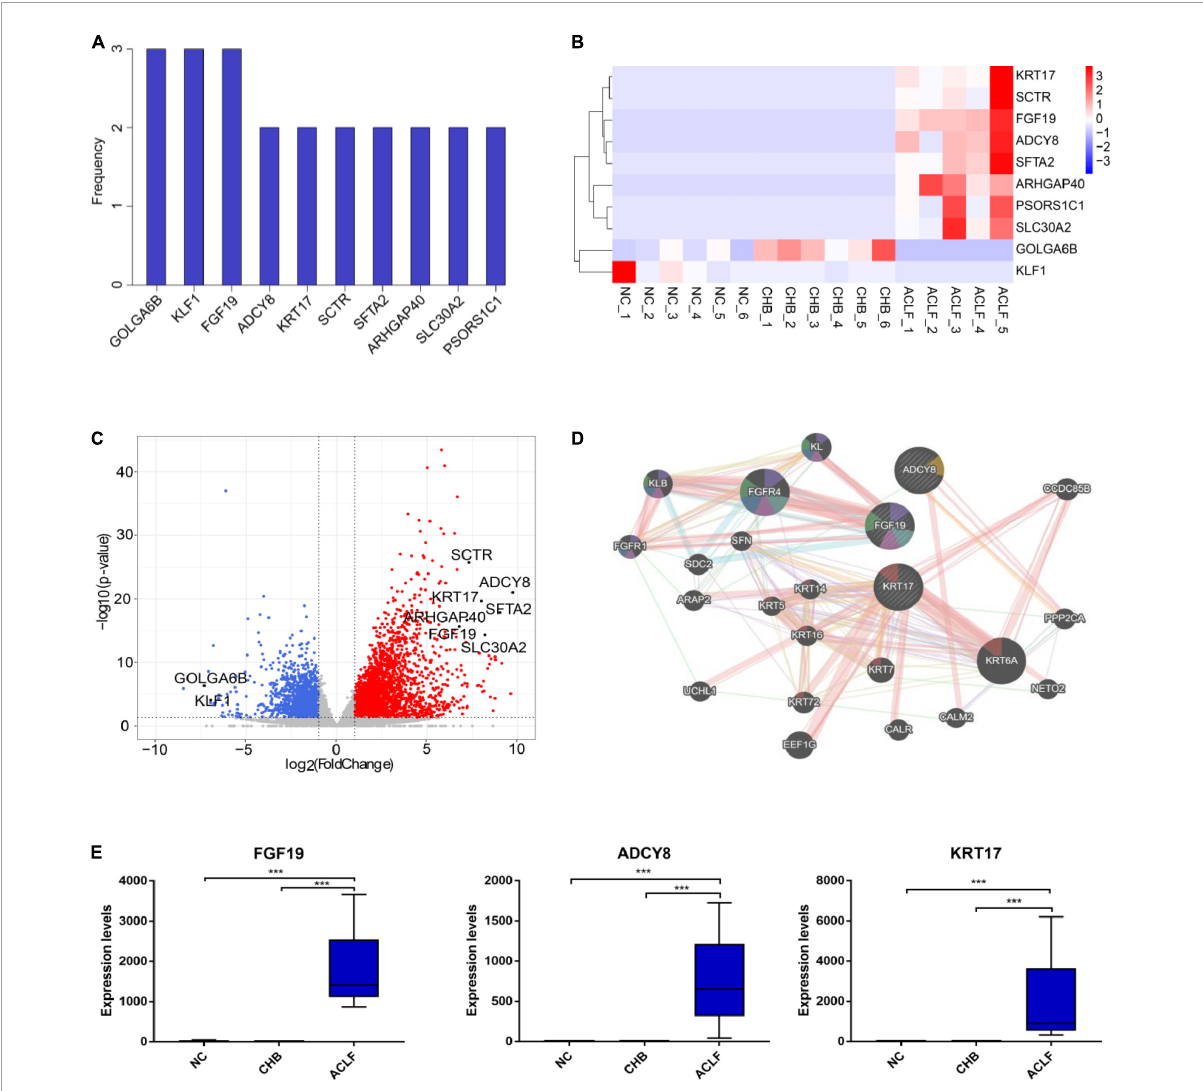
FIGURE3 Genes associated with immunometabolism in HBV-ACLF development. (A) The frequencies of the top 10 genes among the top 50 DEGs from the three comparisons (ranked by adjusted p value). (B) Heatmap of 10 DEGs in the three groups. (C) Volcano plot showing the top 10 DEGs in the comparison of the ACLF and NC groups. Red and blue indicate significant DEGs (| log2-fold change| > 1.5; FDR < 0.05). (D) GeneMANIA (http://www.genemania.org) showing the genes interacting with the top three genes (fibroblast growth factor 19, FGF19; adenylate cyclase 8, ADCY8; keratin 17, KRT17). (E) The expression of the three genes in the sequencing cohort. ***Adjusted P value < 0.001. HBV, hepatitis B virus; ACLF, acute-on-chronic liver failure; CHB, chronic hepatitis B; NC, normal control; DEGs, differentially expressed genes; FGF19, fibroblast growth factor 19; ADCY8, adenylate cyclase 8; KRT17, keratin